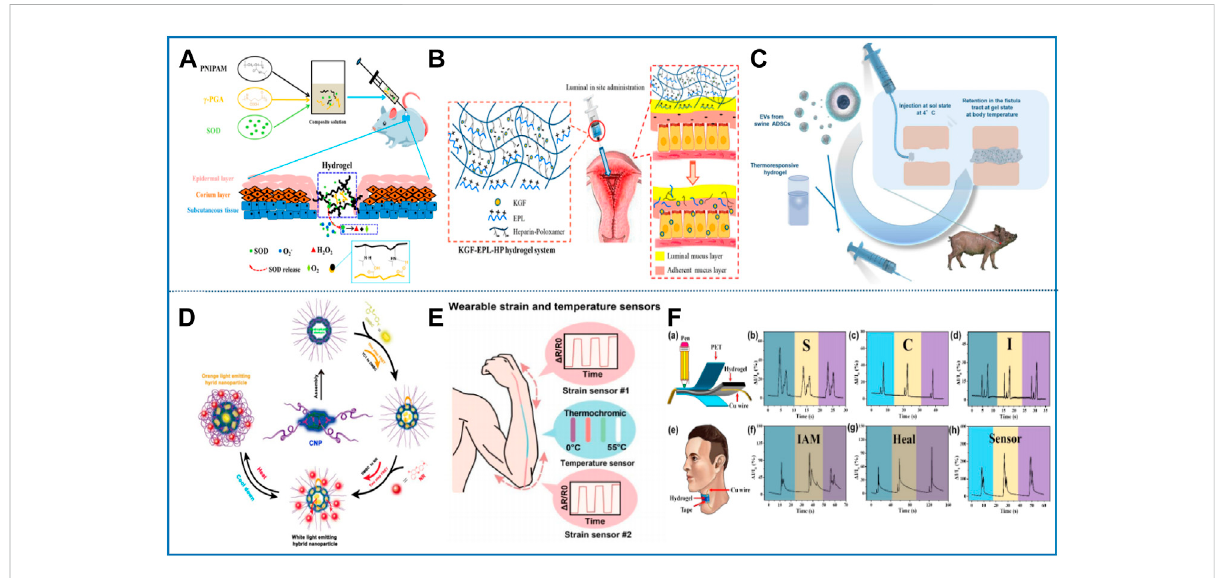
FIGURE 7 Representative studies of thermosensitive nanomaterials in tissue engineering and sensing analysis. (A) Poly (N-Isopropyl-acrylamide)/poly ( γ - glutamic acid) thermo-sensitive hydrogels loaded with superoxide dismutase for wound dressing application. Reprinted with permission from Dong et al. (2020). Copyright © 2020 International Journal of Nanomedicine. (B) Scheme of thermo-sensitive bioadhesive KGF-EPL-HP hydrogel for injured uterus. Reprinted with permission from Xu et al. (2017). Copyright © 2017 American Chemical Society. (C) Thermoresponsive hydrogel gelling insitu atbodytemperaturewasadministeredlocallyintothe fi stulatractofapig.ReprintedwithpermissionfromSilvaetal.(2018).Copyright © 2018 American Chemical Society. (D) Graphical representation of CNP assembles into hybrid nanoparticle. Reprinted with permission from Wang et al. (2020). Copyright © 2019 American Chemical Society. (E) Multifunctional conductive hydrogel/thermochromic elastomer hybrid fi bers with core – shell segmental con fi guration for wearable strain and temperature sensors. Reprinted with permission from Chen J. et al (2020). Copyright